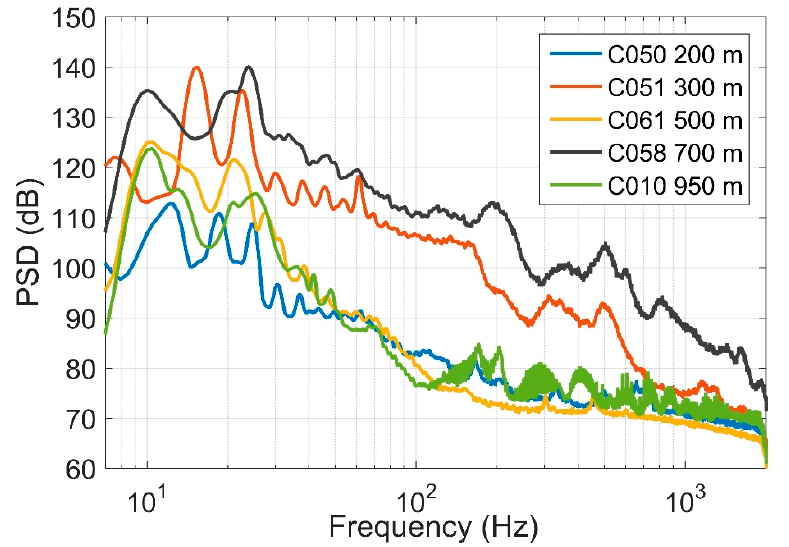
Figure 7. Power spectra comparison of ISW noise from five hydrophones at different depths from 18:06 to 18:08 UTC+8 on 14 March 2017. 18:06 to 18:08 UTC+8 on 14 March